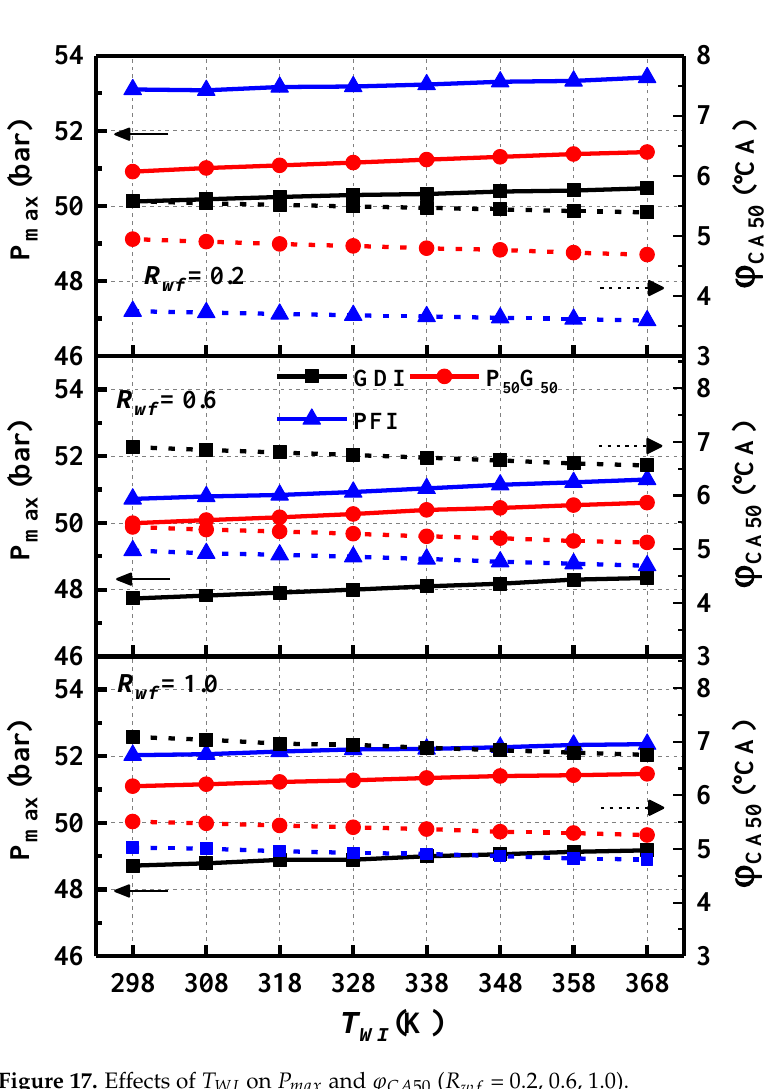
Figure 17. Effects of T WI on P max and ϕ CA 50 ( R wf = 0.2, 0.6, 1.0).